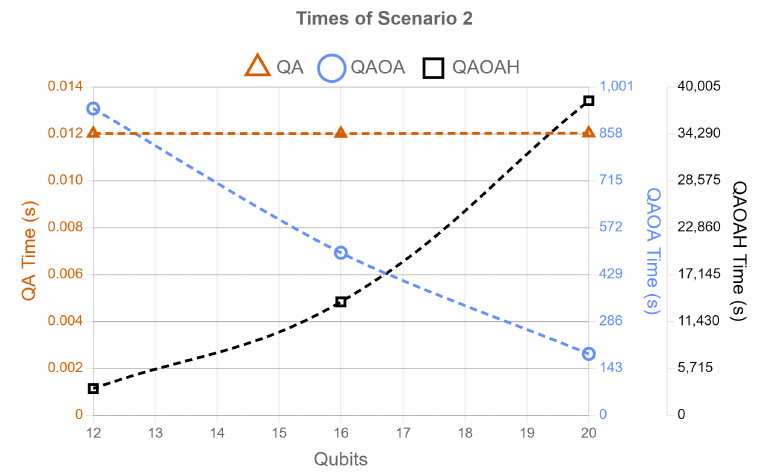
Figure 8. QPU and Simulated Results QA and QAOA QPU times and simulated QAOAH wall-clock times for Scenario 2. QA timing includes the anneal time of each 50 samples, each 20 microseconds per sample. QAOA ran with 1000 shots. QAOAH ran an undetermined amount of jobs using the statevector-simulator to obtain results. Unlike Scenario 1, the times recorded are total wall-clock times for